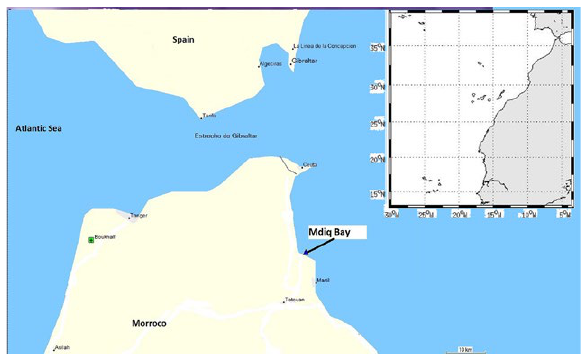
Fig. 1. – Location of M’diq Bay on the northwest coast of Morocco (near Strait of Gibraltar, SW Mediterranean Sea), where Acan- thocardia tuberculata were